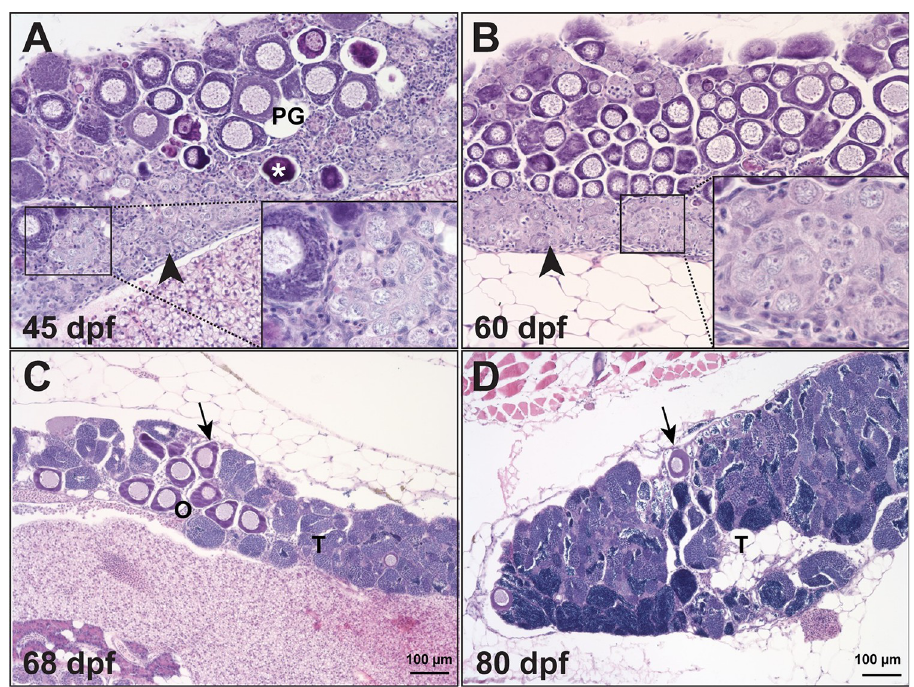
Fig 3. Temporal process of sex reversal from females to males. Sex reversal in gdf9 mutant started around 45 dpf when the follicles were undergoing degeneration (asterisk) while stromal tissue with early spermatogenic cells (inset) was infiltrating the ovarian tissue, which normally started from the ventral side of the ovary (arrowhead). The number of PG follicles (arrow) decreased progressively during the sampling period (45–80 dpf) with increasing amount of testicular tissue